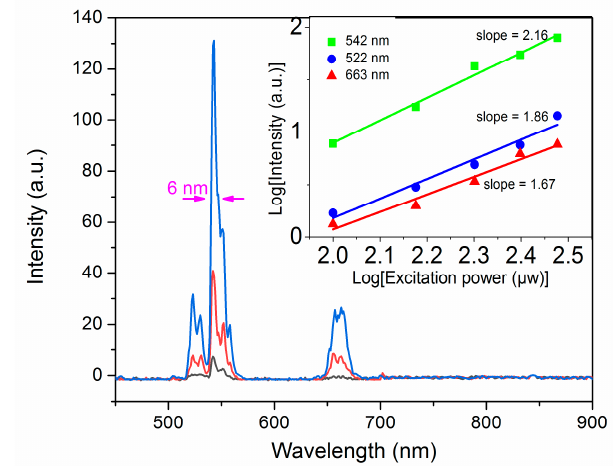
Figure 3. Up-conversion luminescence spectra of NaYF 4 :20%Yb,2%Er by 980 nm excitation at room temperature. The inset is the log-log plots of emission intensity of different emission bands versus excitation power for the NCs.